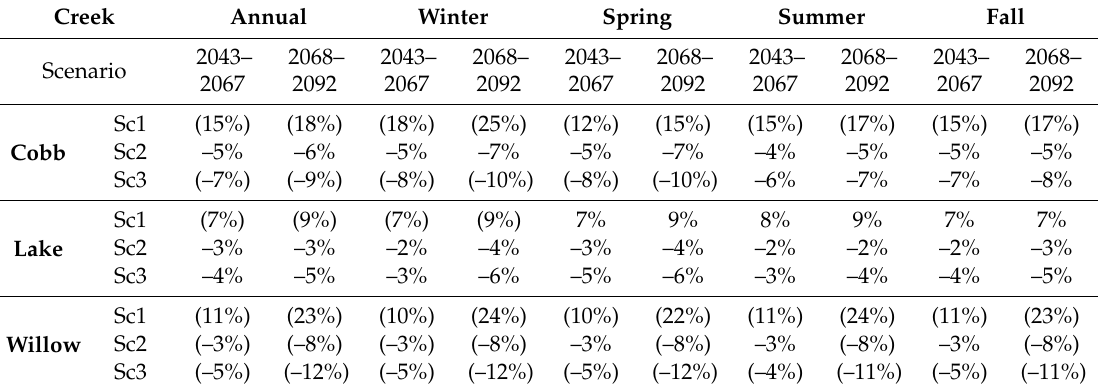
Table 2. Changes in mean seasonal streamflow at the Cobb, Lake, and Willow Creek in the 2043–2067 and 2068–2092 periods for the di ff erent scenarios compared to the baseline. Significant changes in